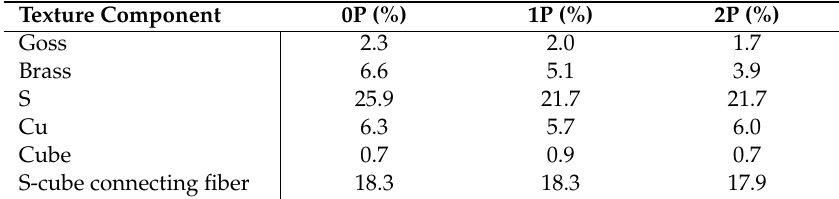
Table 2. Changes of the texturized volume for the components Goss, brass, S, Cu, cube, and the S-cube connecting